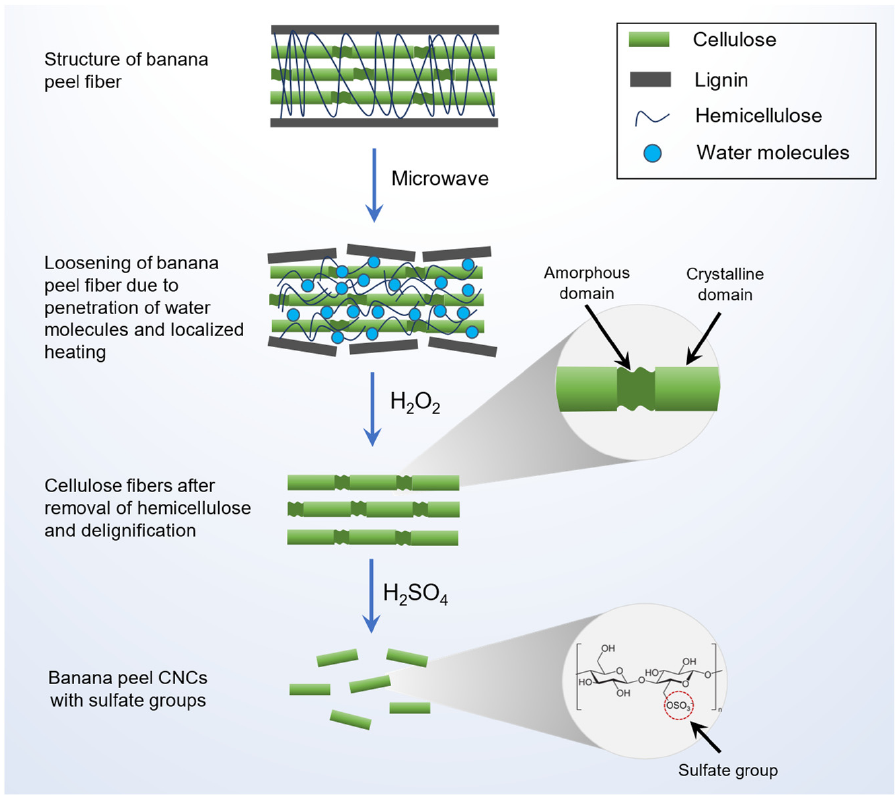
Figure 2 . Mechanism of CNCs formation through one ‐ pot microwave and oxidative hydrolysis . Figure 2. Mechanism of CNCs formation through one-pot microwave and oxidative